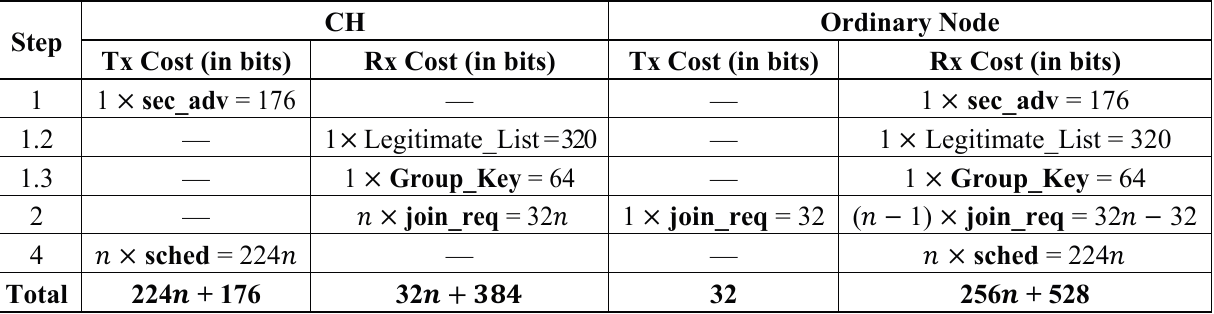
Table 11. Communication cost of MS-LEACH in setup phase.